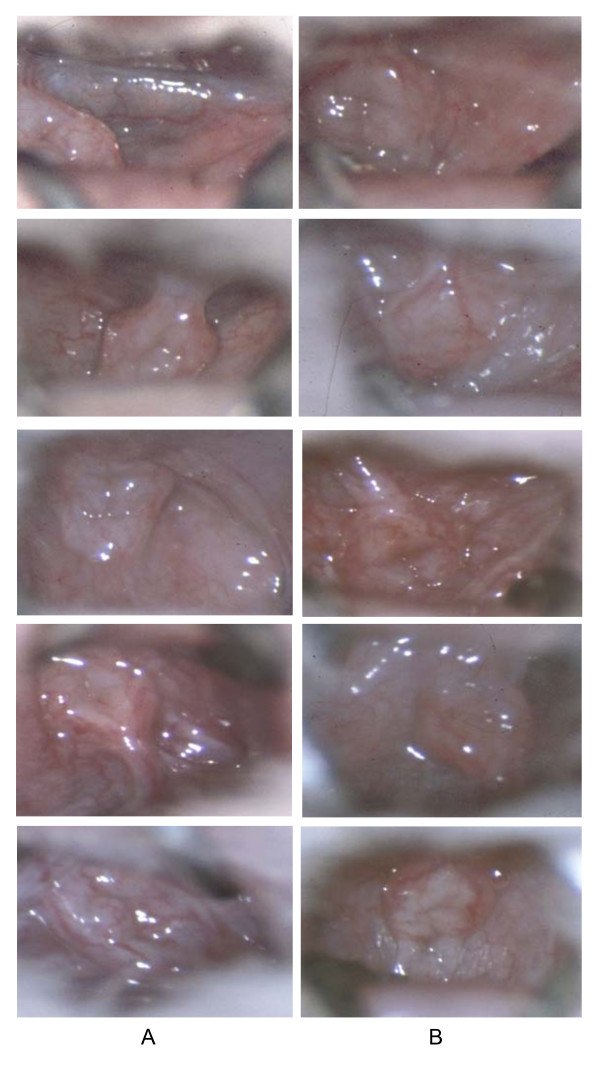
Colposcopic images of mouse vaginas 12 hours after a single exposure to 2% N9, or PBS. The colposcope (Zeiss OPMI 1-SH) was set at maximum magnification (31×) and focused on the vaginal area surrounding the cervix. Column A, 2% N9, column B, PBS controls.